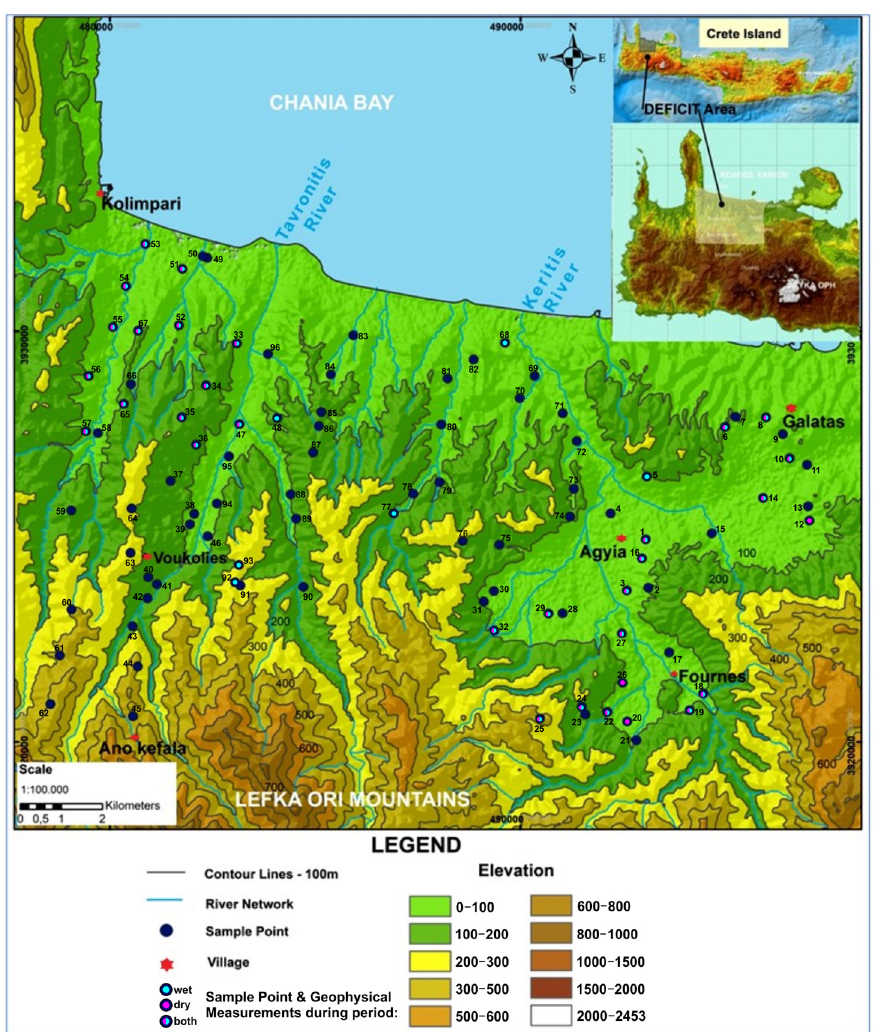
Figure 1. Morphological map (data from SRTMGL1 v003, NASA Shuttle Radar Topography Mission Global, 1 arc second) of the study area, indicated by the gray polygon (see the embedded Google Earth map and relief map) in the western part of Crete (Greece) in the eastern Mediterranean